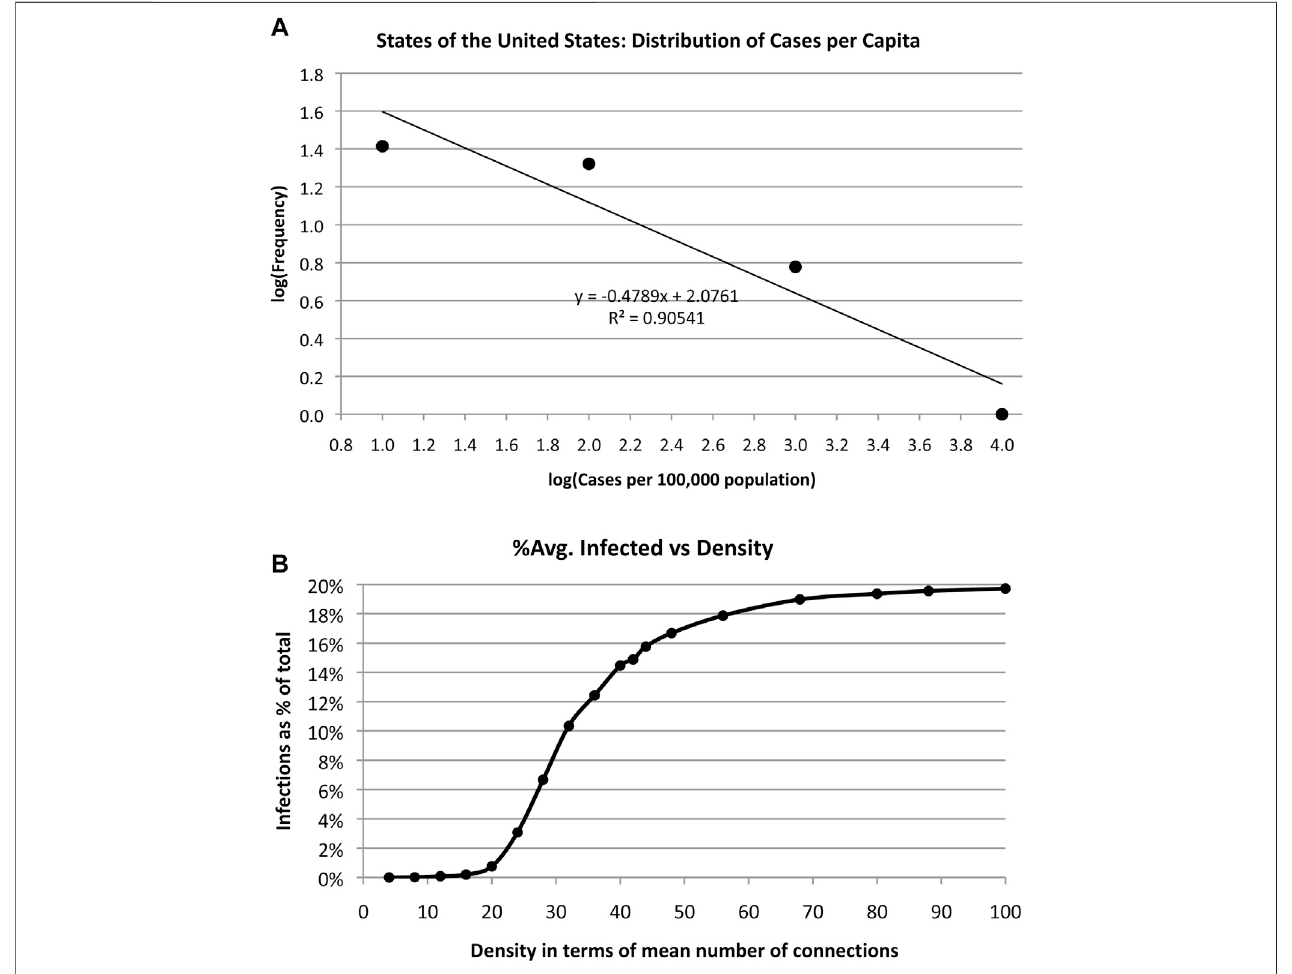
FIGURE 6 | (A) The distribution of COVID-19 spreading obeys a power law vs. the number of cases per capita as shown in this log-log plot. (B) . Simulation of average number of infections in a random network of 500 actors and 5% infection rate shows that number of infections increases with density of network links.